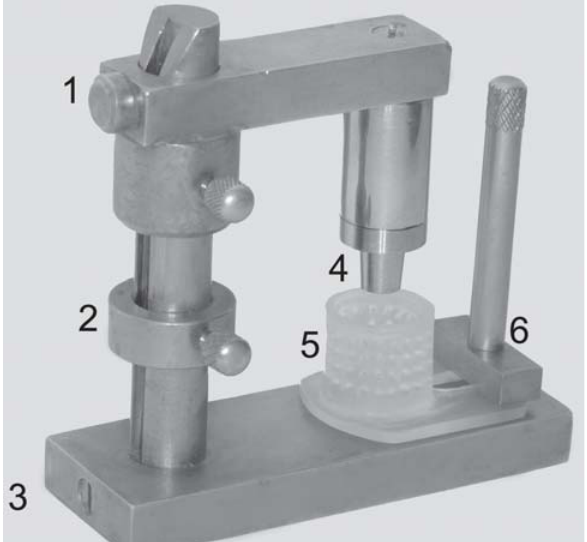
FIGURE 1- Apparatus used to take the impressions: 1) the upper part slides on the vertical axis of the base until it reaches a stop (2); 3) base of the apparatus; 4) steel die; 5) perforated acrylic impression tray fixed at the base of the apparatus with a metallic screw and bar